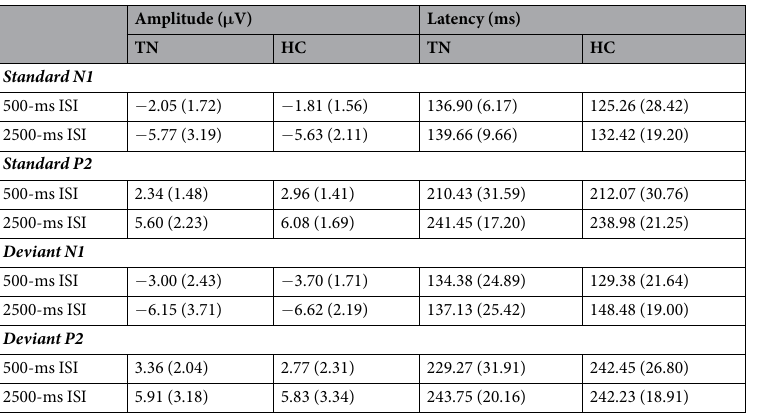
Table 2. Peak amplitude and latency of N1 and P2 to standard and deviant tones under different ISI conditions at Cz electrode in experiment 1. TN, Trigeminal neuralgia patients; HC, healthy